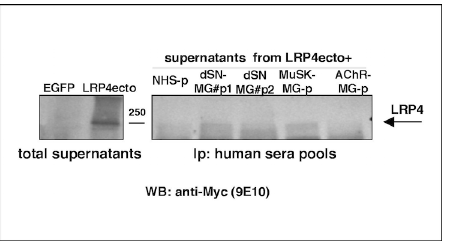
Fig 3. Anti-LRP4 detection by immunoprecipitation of pools of sera. Supernatants from LRP4ecto HEK293T cells were immune-precipitated with the indicated pools (p) of sera that scored positive at FACS analysis: pool#1 and #2 from dSN-MG, Musk-MG pool and AChR-MG pool. Immuno-complexes were subdued to western blotting and probed with anti-c-Myc. Aliquots of total supernatants from EGFP-HEK293T and from LRP4ecto HEK293T cells were blotted alongside with immune-precipitates as negative and positive control, respectively. The specific, uppermost band is pointed by the arrow.